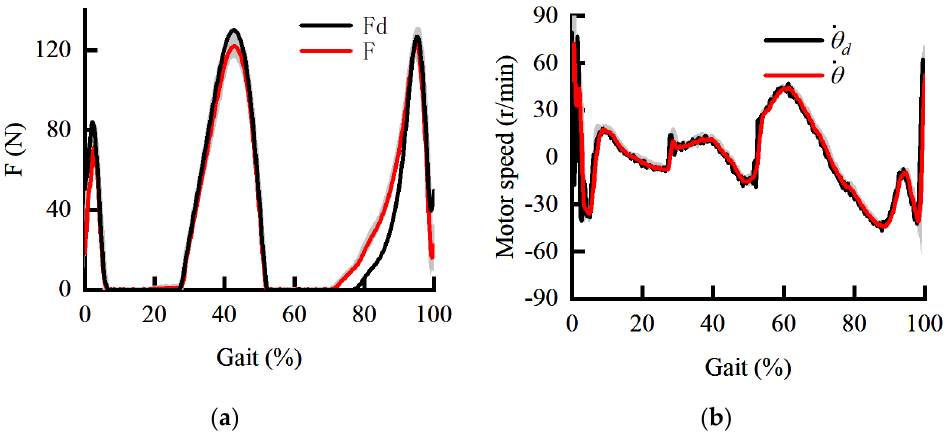
Figure 13. The dynamic curve under the HEIF in the outer loop and DOB in the inner loop during walking. ( a ) The dynamic curve of force response; ( b ) the dynamic curve of speed response.